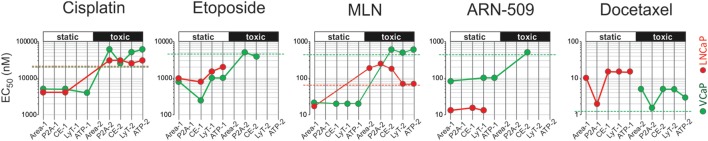
High-content analysis plots for drug response in VCaP and LNCaP spheroids. The plots were constructed using the data in Tables 3 and 4. The EC50 values were estimated from dose–response curves for “Area,” “Shape P2A” (P2A), “CellEvent” (CE), “LysoTracker” (LysoT), and ATP parameters, which were measured in VCaP (green circles) and LNCaP (red circles) spheroids. The increments “−1” and “−2” indicate lower and higher values, respectively. The threshold lines correspond to the drug concentration at which no change in spheroid ATP content was observed within a given treatment time [2 days for LNCaP (red line) and 4 days for VCaP (green line)]. The EC50 values below the threshold were tentatively assigned to the cytostatic drug effect, whereas those above the threshold were assigned to the cytotoxic drug effect.